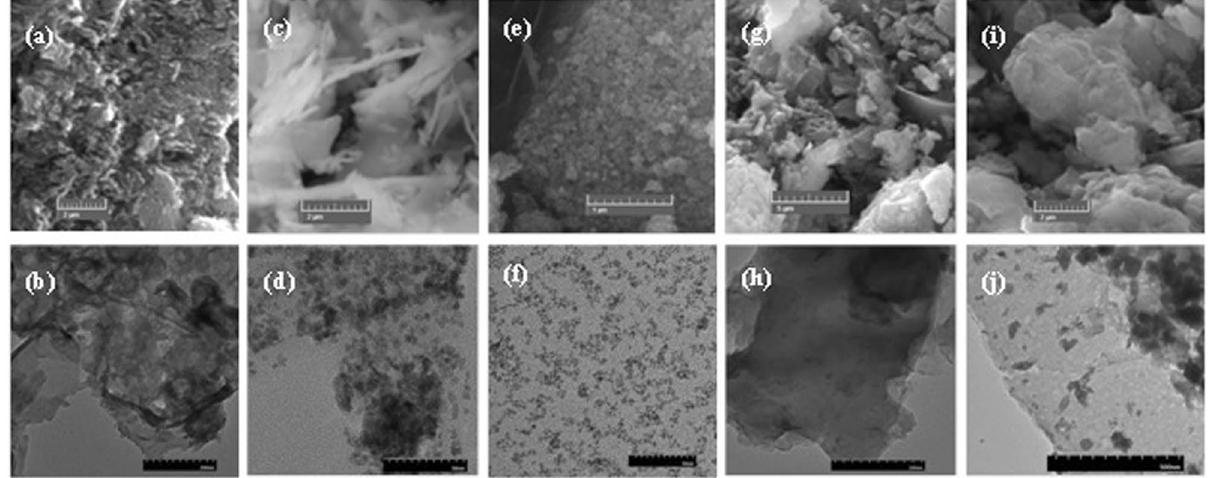
Figure 3. Respective SEM and TEM images ( a,b ) pristine g-C 3 N 4 , ( c , d ) CeO 2 , ( e,f ) Fe 3 O 4 , ( g,h ) binary composite